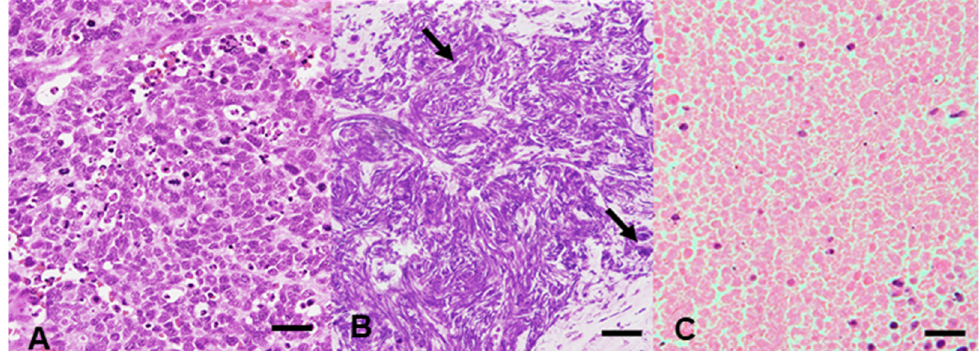
Figure 1. Histological features of the materials with a well-preserved tumor morphological compo- nent ( A ), nuclear streaming samples ( B ) (the arrows show the shape-preserved cells), and necrotic samples ( C ). ( A – C ) Hematoxylin and eosin staining; original magni fi cation, ×200; bar, 100